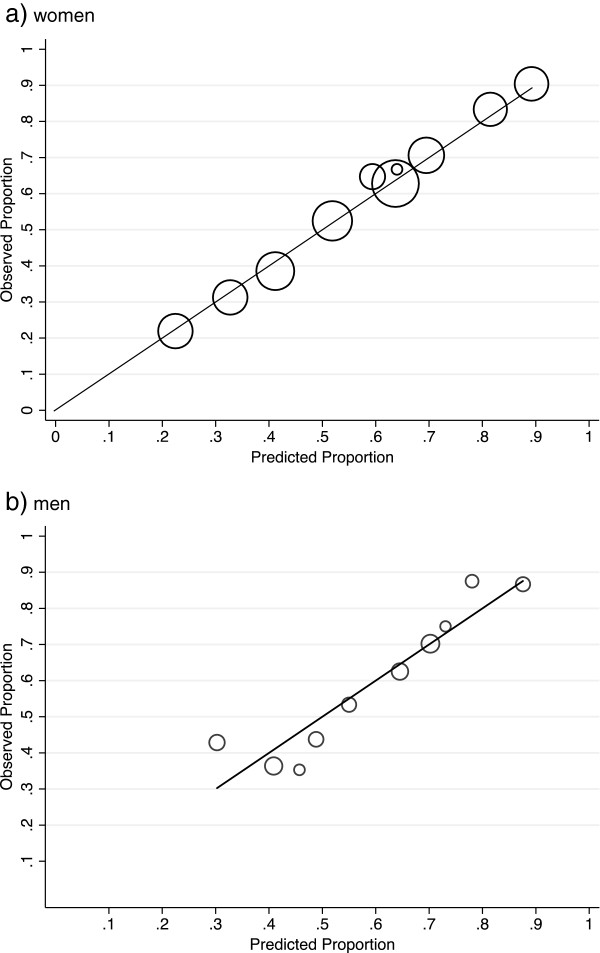
Observed proportion of melanoma cases compared with the predicted proportion, based on the risk predictor model, for men and women. Circle size is proportional to the total number of cases in each of 10 data subsets. a) women (p for Hosmer-Lemeshow test = 0.99) b) men (p for Hosmer-Lemeshow test = 0.70).